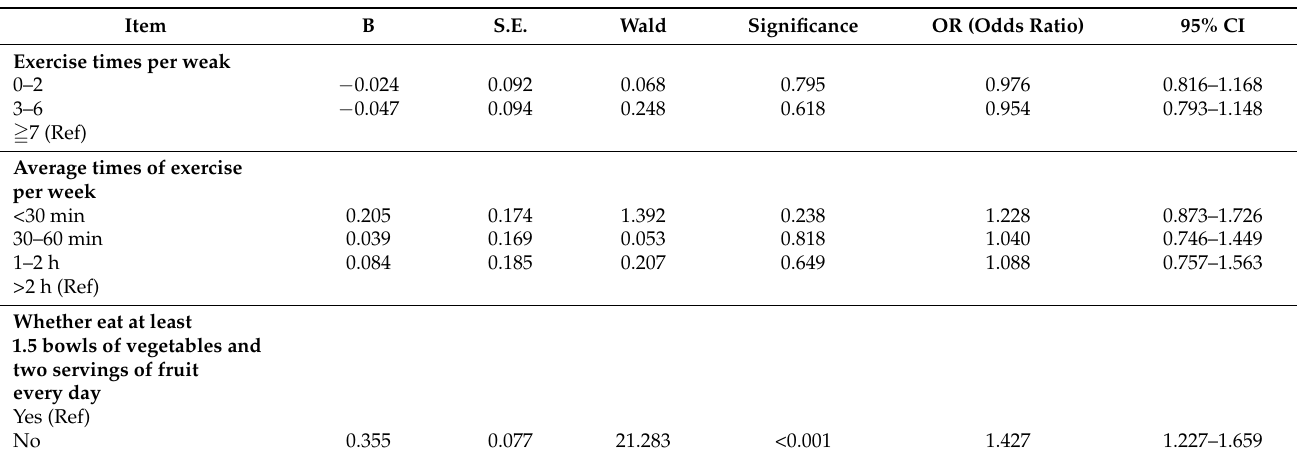
Table 6. Logistic regression analysis of participants’ health